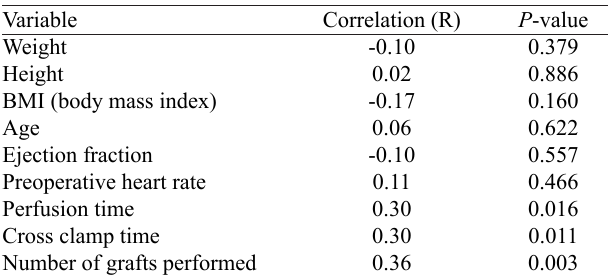
Table 5. Correlation between troponin I at 12 hours of postoperative and variables which could influence its release.